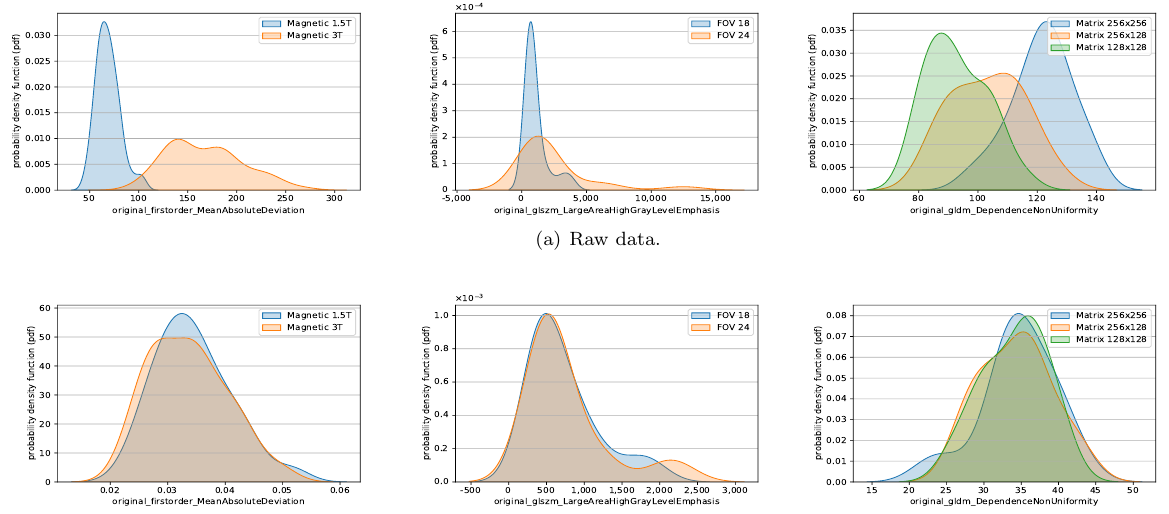
Figure 8. Histograms of example radiomic features of the raw data and the harmonized data of healthy volunteers, with different magnetic field strengths (first column), FOVs (second column) and matrices (third column). ( a ) The histograms of the example features of the raw data. ( b ) The histograms of the example features after applying the image resampling, FCM-based normalization and parametric ComBat